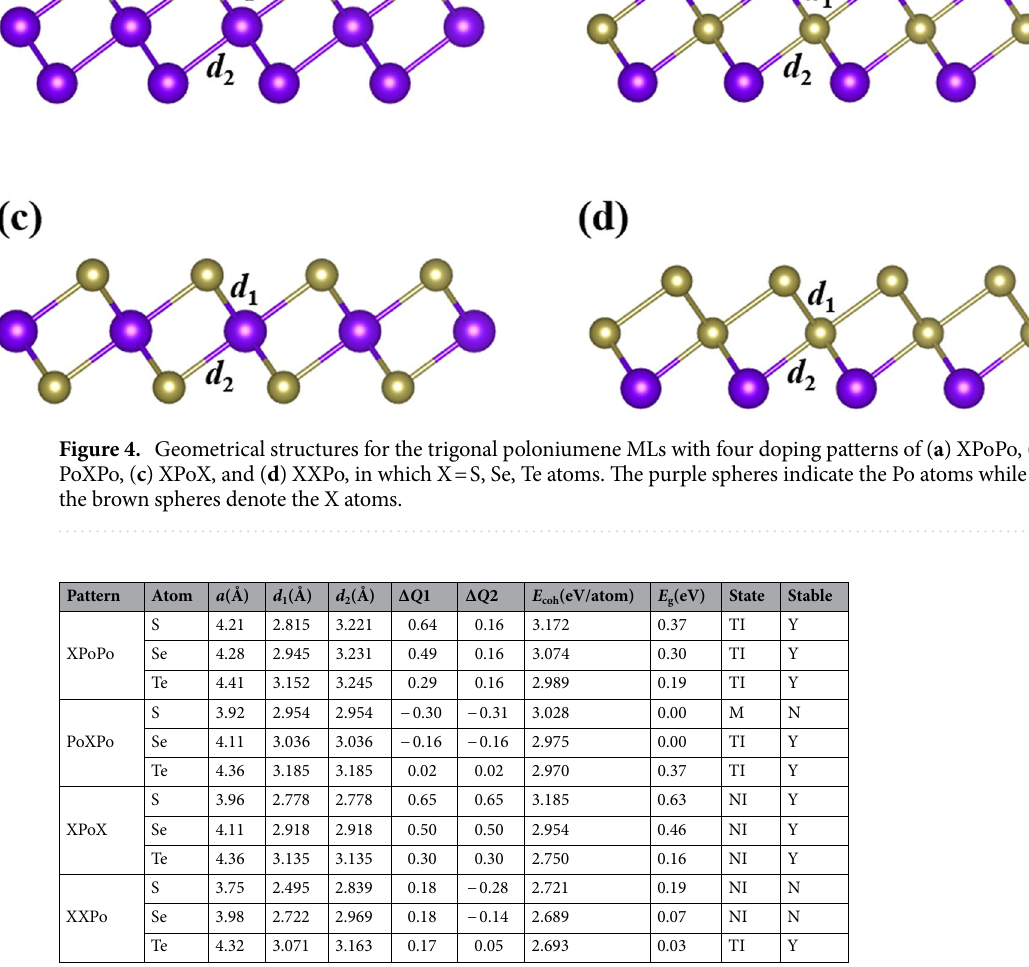
Table 1. The lattice constant a , bond length d 1 ( d 2 ) between the central-layer atom and the up-layer (low- layer) atom, charge transfer ΔQ1 (ΔQ2) from the central-layer atom to the up-layer (low-layer) atom, cohensive energy E coh , band gap E g , electronic states (including normal insulating (NI), metallic (M), and TI), and dynamic stability for the trigonal poloniumene ML with X (X = S, Se, Te) atoms doped. The SOC is